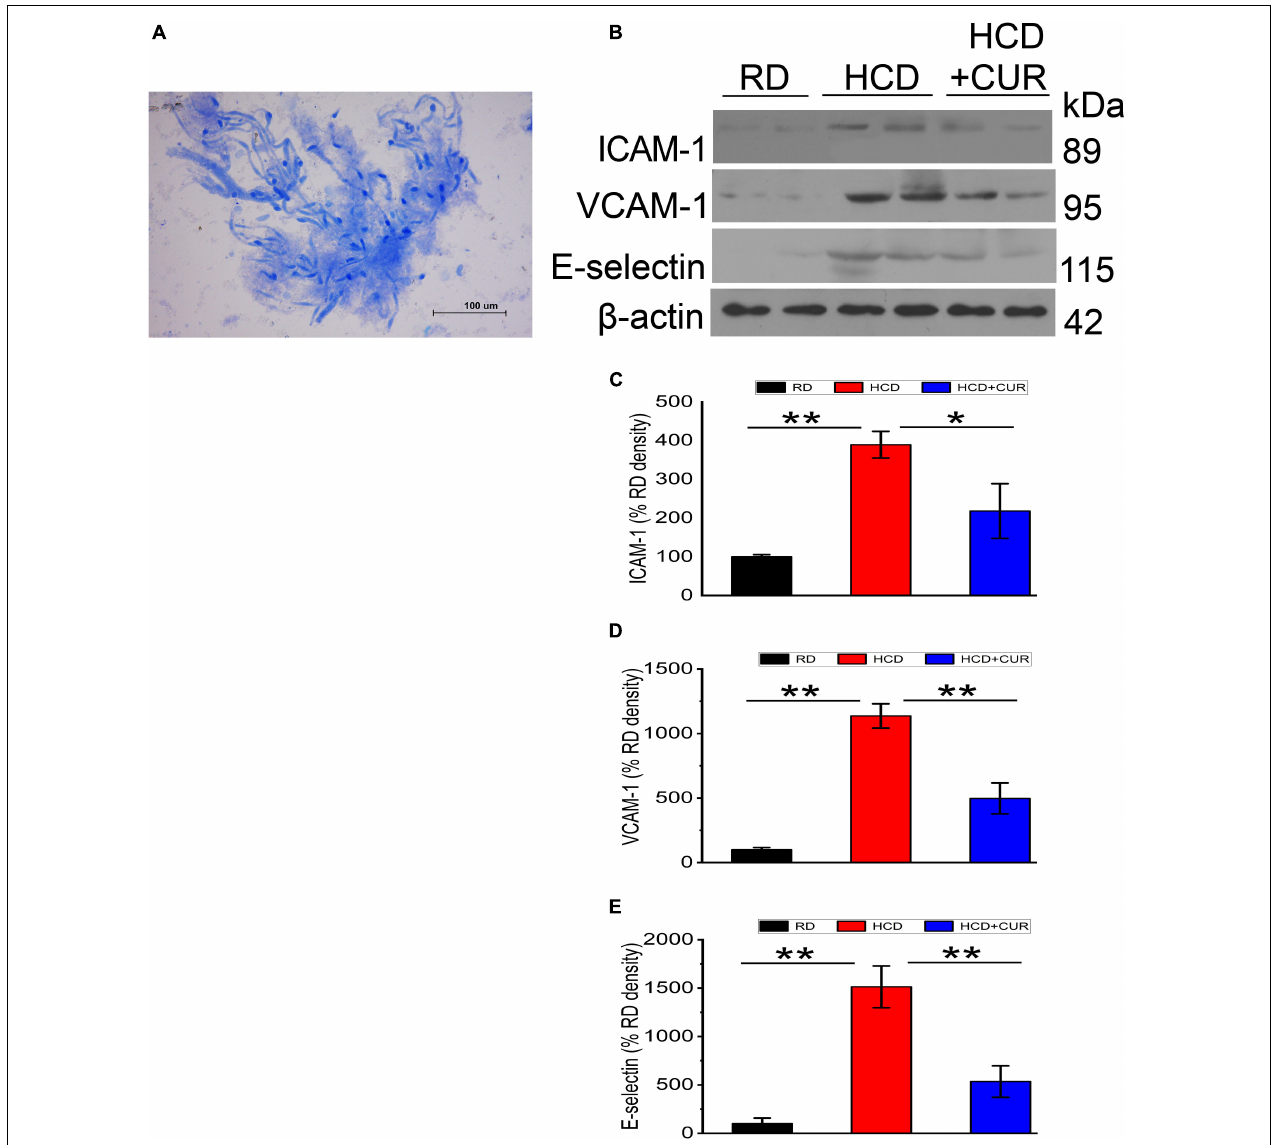
FIGURE 5 | Changes in expression levels of ICAM-1, VCAM-1, and E-selectin in the cerebral microvasculature in rats. (A) Light photomicrograph of the isolated microvascular fraction from rat cerebral cortex. Scale bar = 100 µ m. (B–E) Representative western blot of ICAM-1, VCAM-1, and E-selectin in cerebral microvessels. Quantification of ICAM-1, VCAM-1, and E-selectin normalized with β -actin. RD, control group; HCD, high cholesterol diet group; HCD + CUR, high cholesterol diet receiving a daily dose of 200 mg/kg body weight curcumin by gavage for 4 weeks. Carotid injury was induced by an air-drying endothelial denudation method at the end of the second week. Data are representative of two independent experiments and are expressed as mean ± SE, n = 4 for each group. * P < 0.05, ** P <